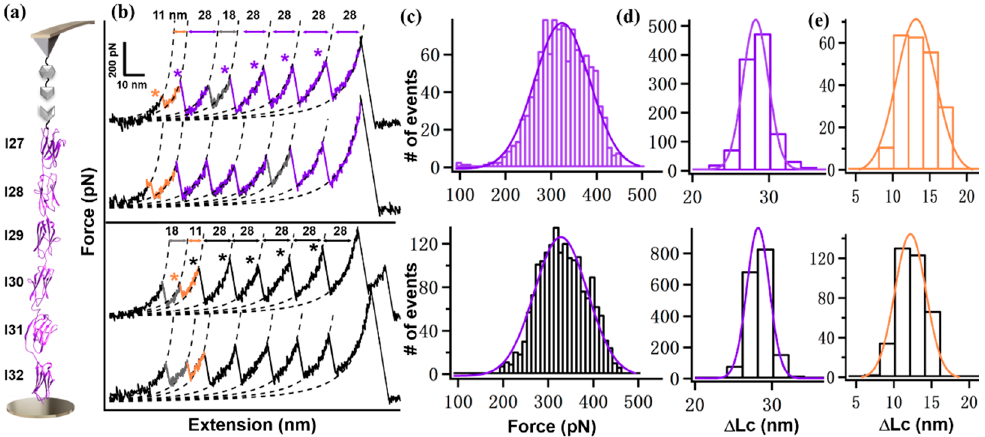
Figure 2. ( a ) Scheme of AFM-SMFS setup to measure the mechanical stability of polyprotein I(27–32). ( b ) Representative force-extension curves show the unfolding events of Ig domains (marked by a star). The top two curves are from the unfolding of polyprotein with an artificial 9G linker (colored in purple) and the bottom curves are from the natural polyprotein sequence without the linker. The I30 domain shows a peak with Δ Lc of 11 nm (in orange), the remaining five Ig domains all show a peak with Δ Lc of 28 nm, and GB1 shows a Δ Lc of 18 nm. ( c , d ) Histograms show the unfolding force ( c ) and Δ Lc ( d ) from the five Ig domains. ( e ) The histogram shows the Δ Lc of I30.